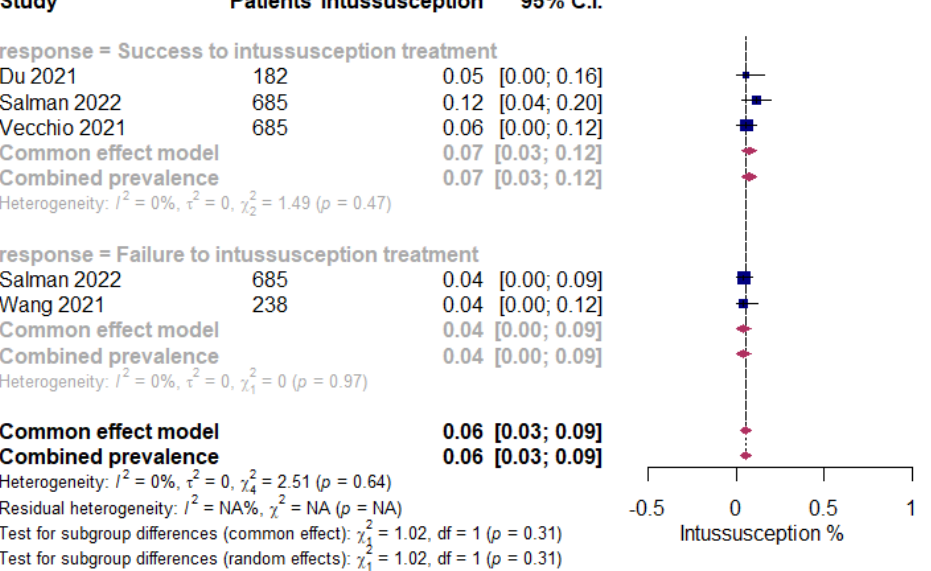
Figure 3. Pooled estimate for the prevalence of ISN in pediatric COVID-19 patients stratified by the failure of pneumatic, hydrostatic or surgical reduction to the ISN.